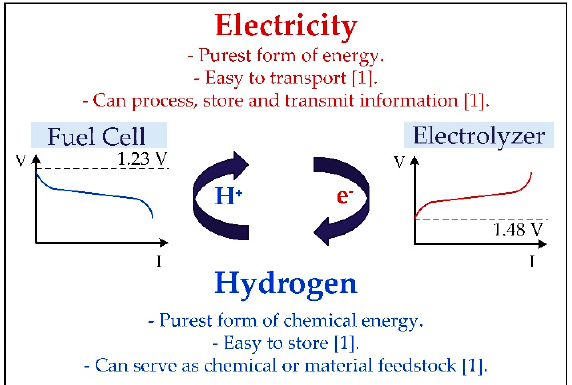
Figure 1. The “H + –e − Cycle” of polymer electrolyte membrane (PEM) fuel cells and electrolyzers.